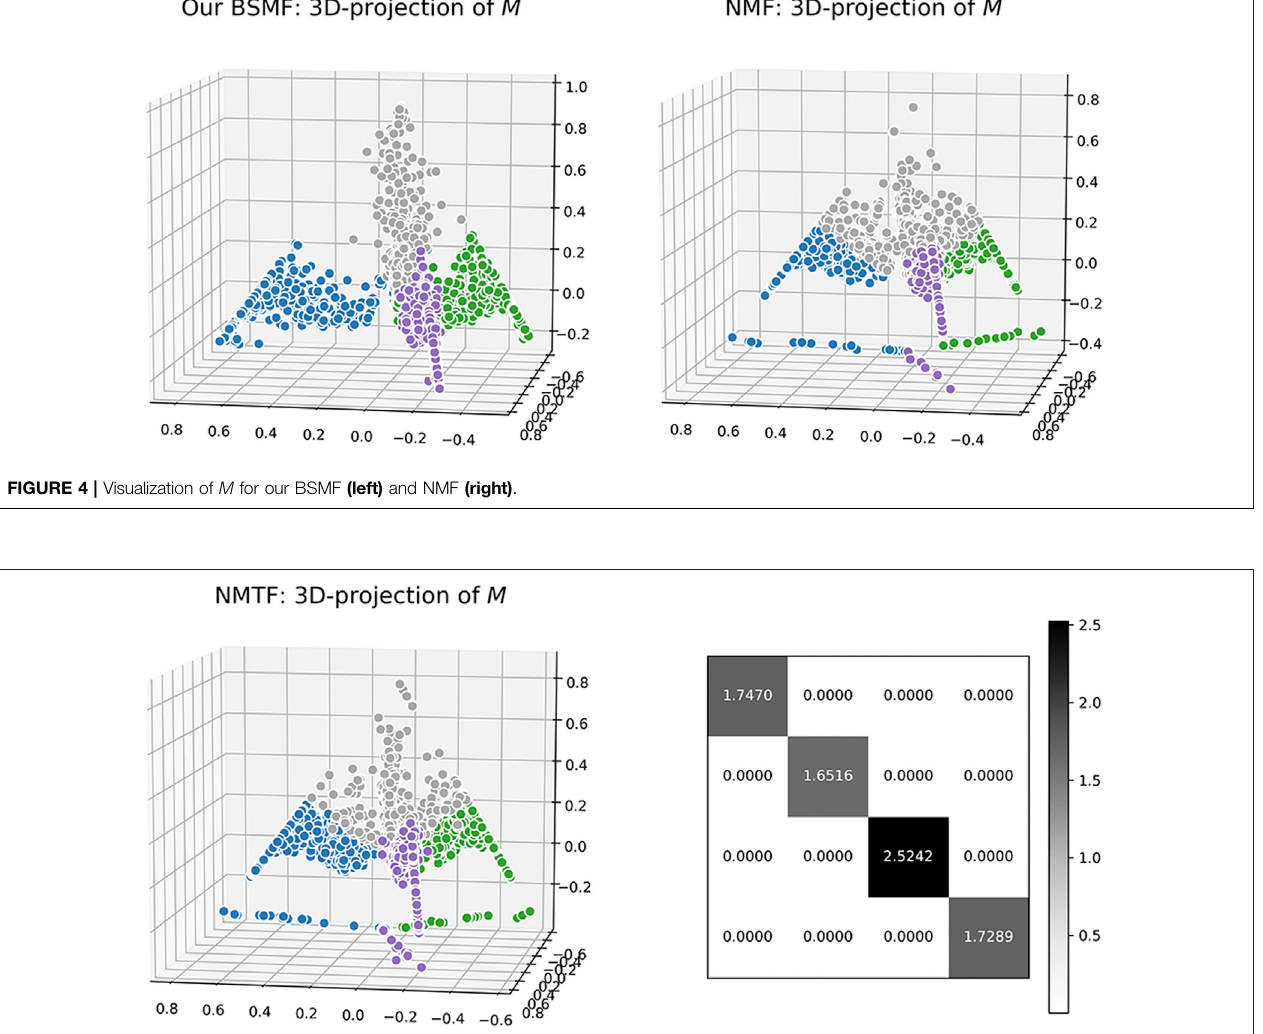
FIGURE 5 | Visualization of M (left ) and ~ B (right) for NMTF.